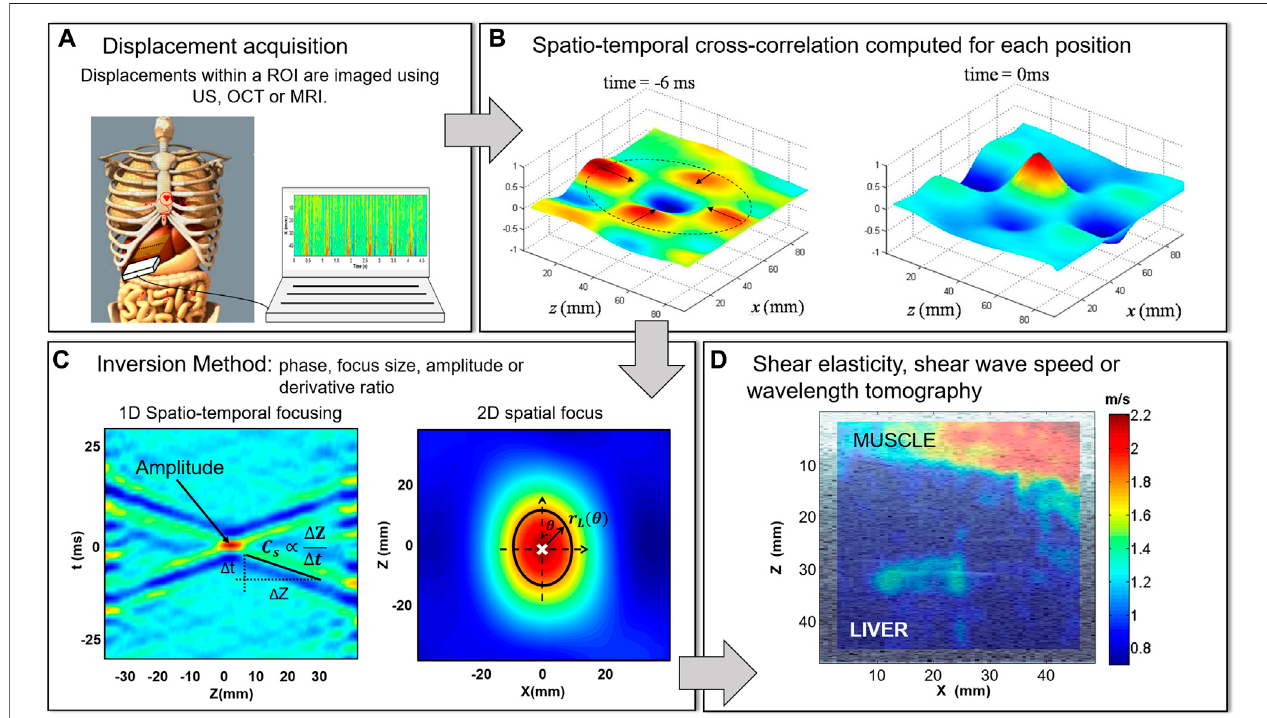
FIGURE 1 | Schemmatic representation of the main steps involved in an elastography experiment based on noise correlation and time reversal (A) The fi rst step consists in recording at least one component of the complex elastic wave fi eld. As an example, we present the acquisition of the physiological noise in the liver using an ultrasound (US) scanner as in [13]. (B) Then, the spatio-temporal cross-correlation fi eld C ( r o → → , r , t ) . At t (cid:1) − 6 ms the shear wave front (indicated by a black dashed line) converges toward r snapshots of C ( r o